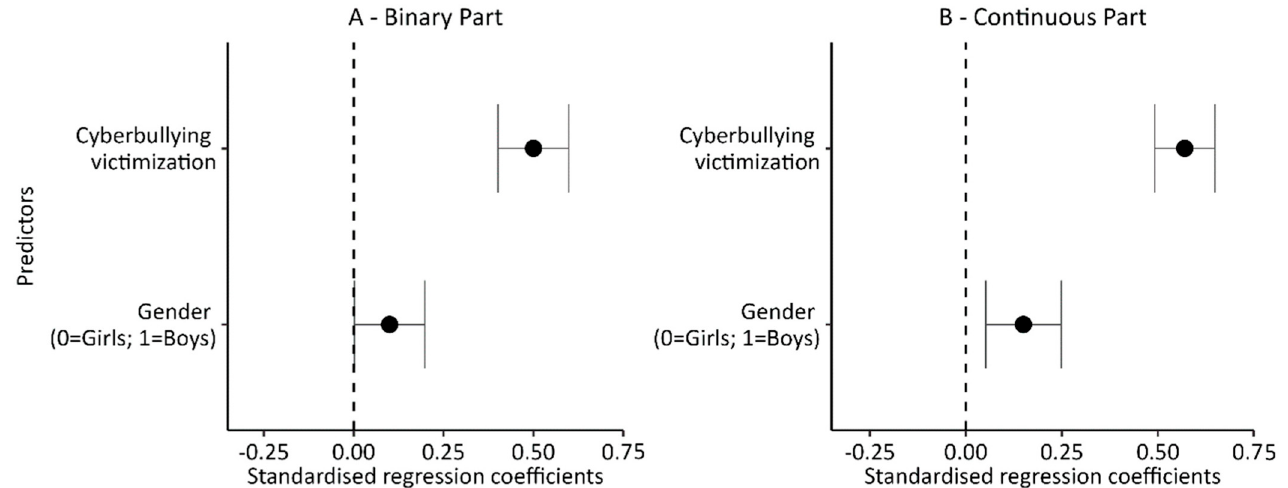
Figure 3. Model 1. Standardised regression coefficients with 95% confidence intervals. Note: Black circle-coefficient significant at 0.05.